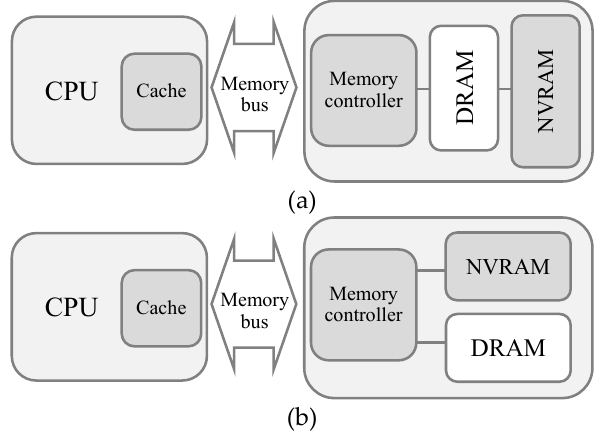
Figure 1. Architecture of the proposed system. ( a ) Hierarchical memory architecture, ( b ) hybrid memory architecture.